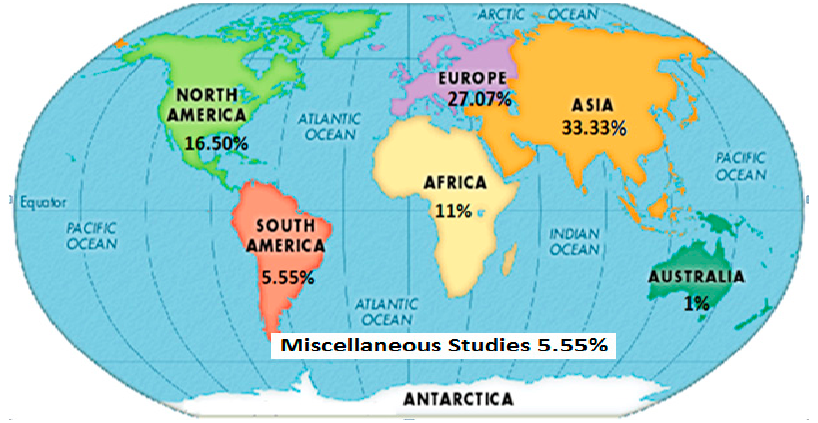
Figure 4. Studies distributed by continents.